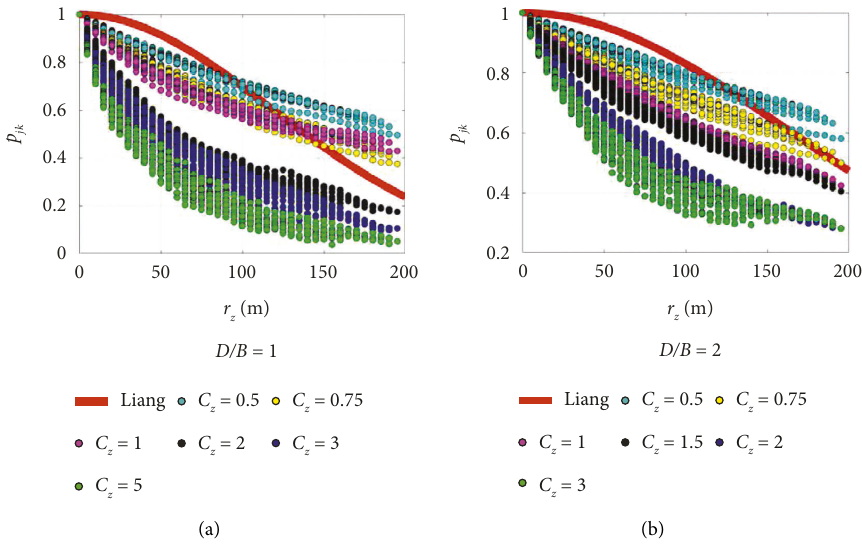
Figure 7: Vertical correlation for wind-induced torque: B/H =